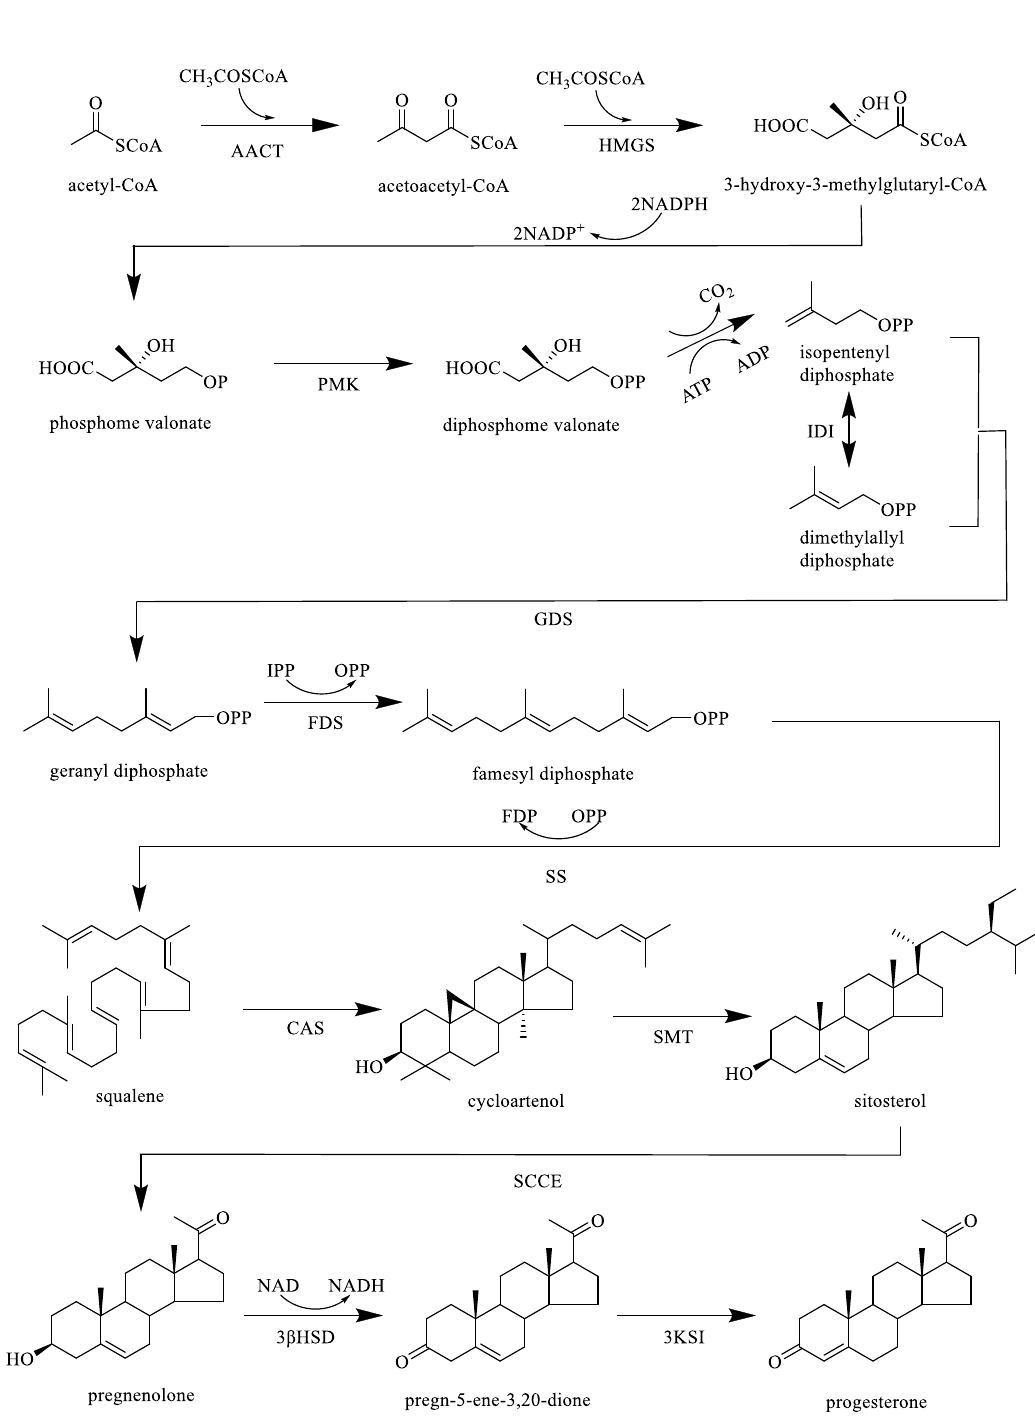
Figure 2. Biosynthesis pathway of C 21 -steroids. (Note: AACT: acetoacetyl-CoA thiolase, HMGS: 3-hydroxy-3-meth- ylglutaryl-CoA synthase, PMK: phosphomevalonate kinase, IDI: isopentenyldiphosphate isomerase, GDS: geranyl diphos- phate synthase, FDS: farnesyl diphosphate synthase, SS: squalene synthase, CAS: cycloartenol synthase, SMT: sterol methyl- transferase, SCCE: side-chain cleaving enzyme, 3βSD: 3β -hydroxysteroiddehydrogenase, 3KSI: 3-ketosteroidisomerase.